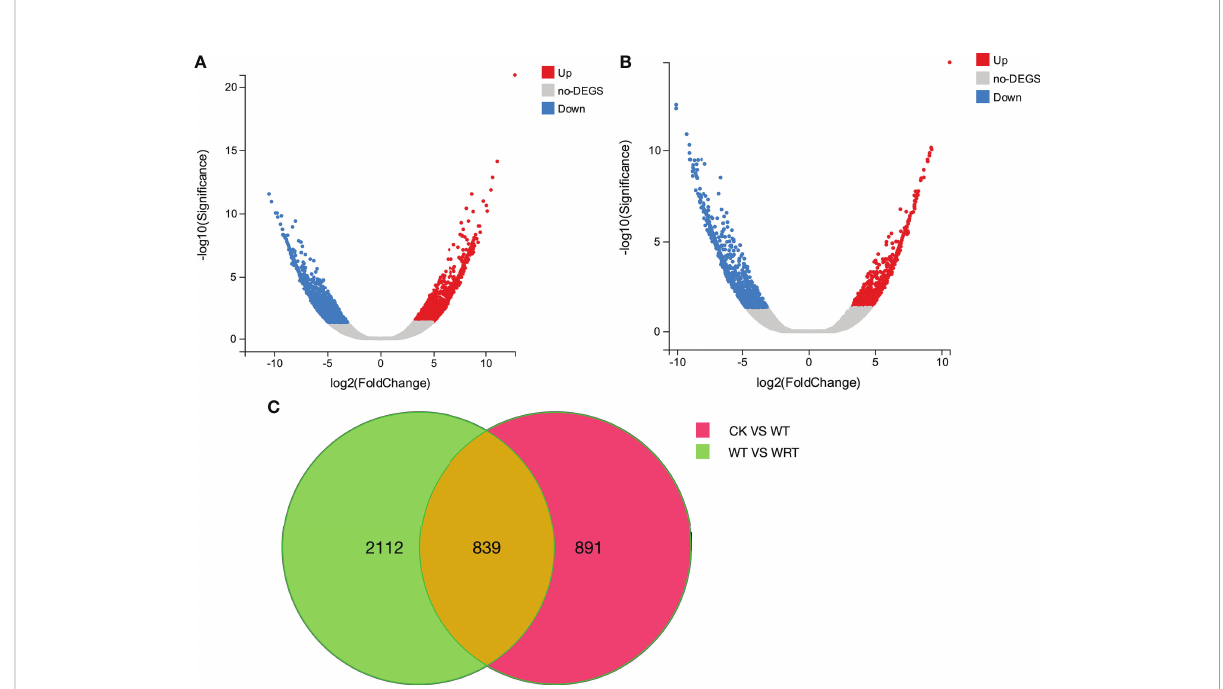
FIGURE 3 The distribution and expression levels of DEGs in P. ostii roots. (A) , Volcano plot of waterlogging treatment (CK VS WT); (B) , Volcano plot of waterlogging recovery treatment (WT VS WRT); (C) , Venn diagram of DEGs under waterlogging and its recovery treatment. The x -axis represents the log 2 [Fold Change] values under the mean normalized expression of all isoforms ( y -axis).